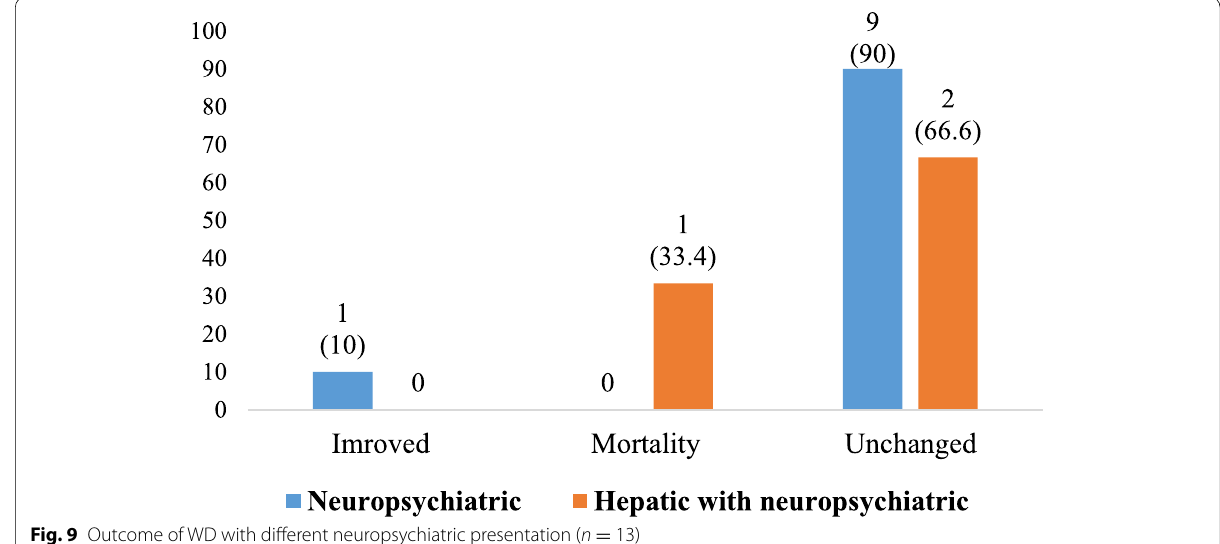
Fig. 9 Outcome of WD with different neuropsychiatric presentation ( n